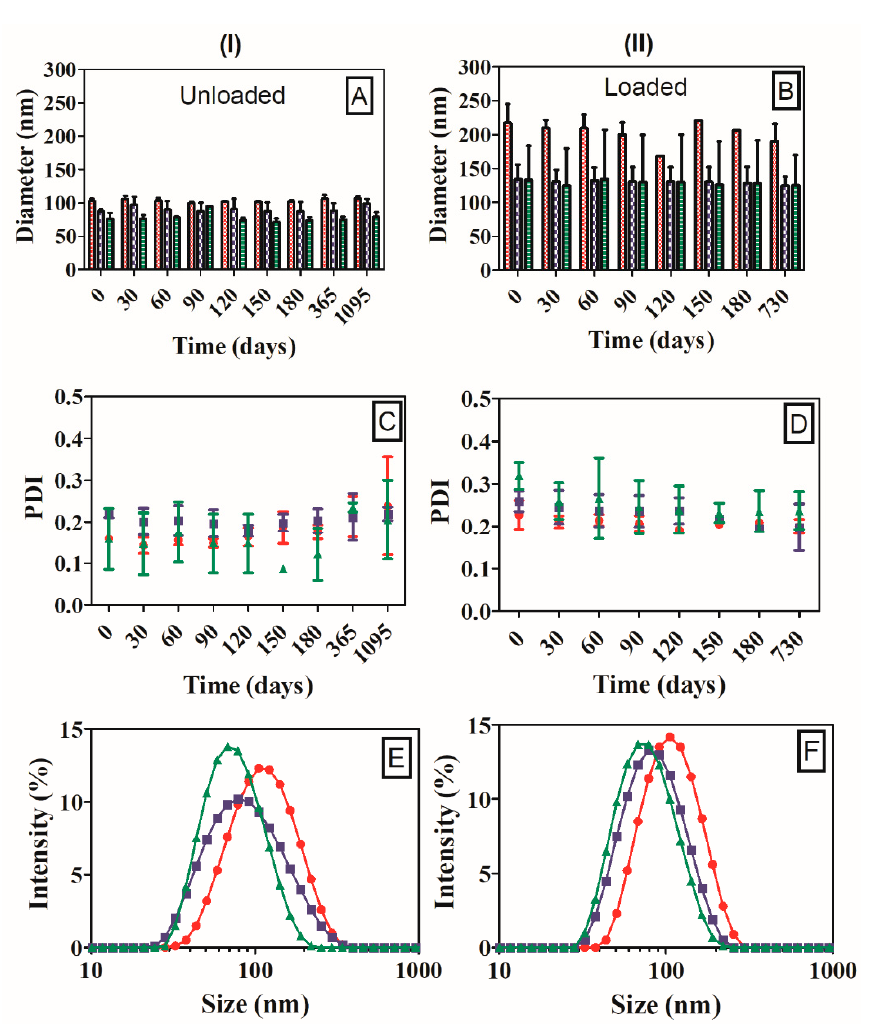
Figure 4. Storage stability and particle size distribution for unloaded and AmB-loaded acylated nanoparticles in aqueous solution at 4 ◦ C. CGAc (red), CGProp (blue), and CGBut (green). Unloaded nanoparticles: Particle size ( A ), PDI ( C ) and size distribution ( E ); AmB loaded nanoparticles: Particle size ( B ), PDI ( D ) and size distribution ( F ), as a function of time.